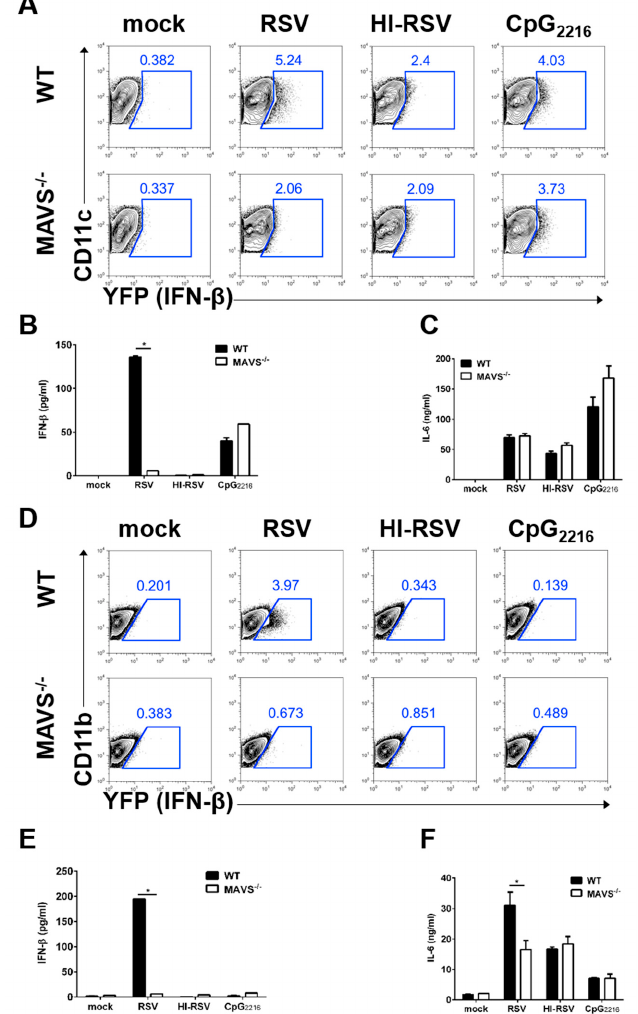
Figure 4. Dependency of MAVS-mediated pathways in the production of IFN- β in BM-DCs and BM- BM-DMs. ( A – F ) BM cells from IFN- β /YFP reporter (WT) mice, or MAVS-deficient IFN- β /YFP reporter (MAVS − / − ) mice were differentiated to become BM-DCs or BM-DMs. BM-DCs (A) or BM-DMs (D) were infected with RSV and heat-inactivated RSV (HI-RSV) at an MOI of 3 or 2.5 µ g/mL CpG 2216 . These cells were harvested 18 h after stimulation and analyzed for IFN- β expression by flow cytometry. Supernatants from BM-DCs (B-C) or BM-DMs (E-F) were collected 18 h after stimulation and analyzed for IFN- β and IL-6 by ELISA. Data are represented as mean ± SEM. The results are representative of three experiments. * p < 0.05 as calculated by Student’s t